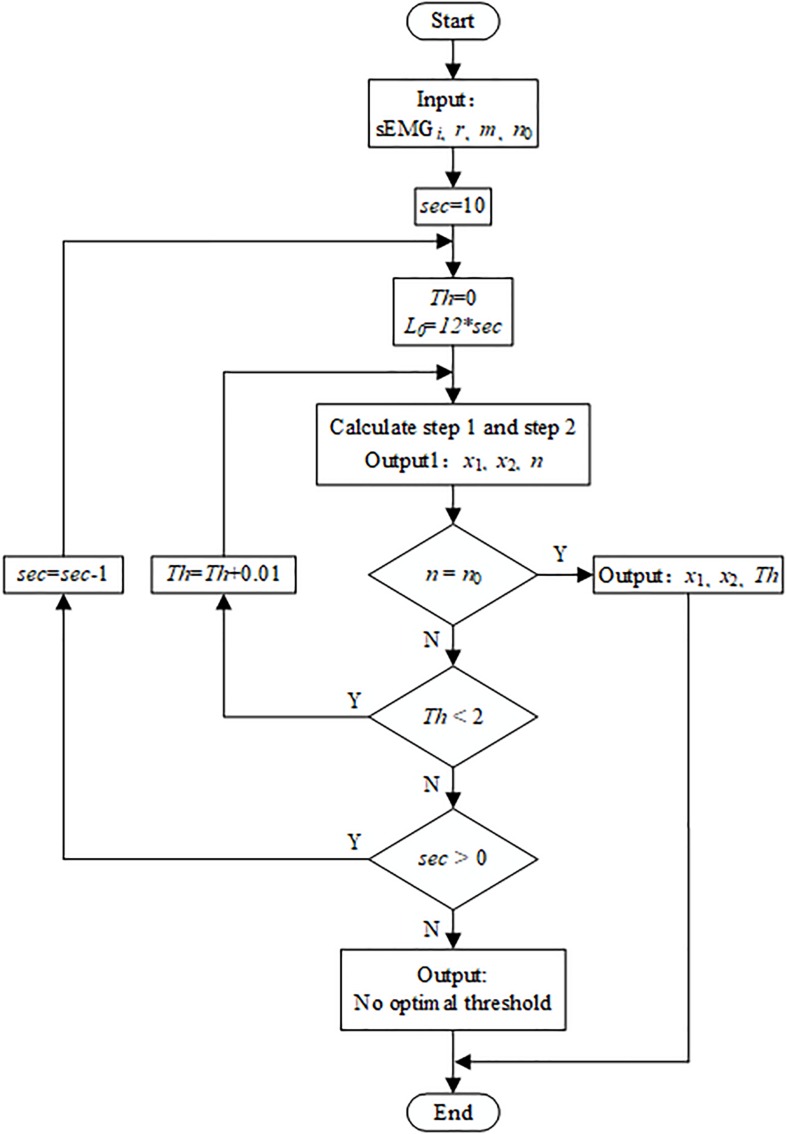
Flowchart for calculating the optimal threshold.